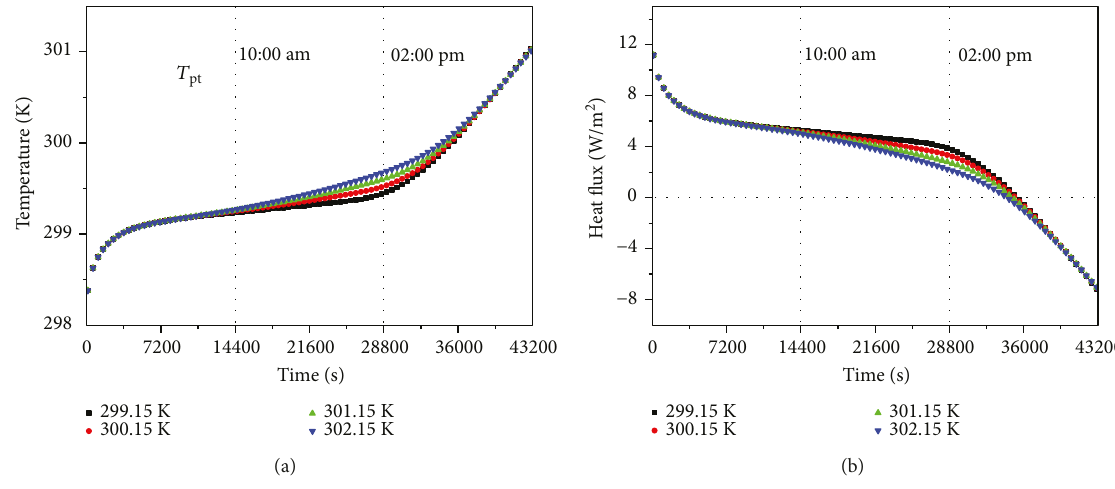
Figure 7: Temperature variation and heat fl ux of the inside wall for case 2 under di ff erent phase transition temperatures.